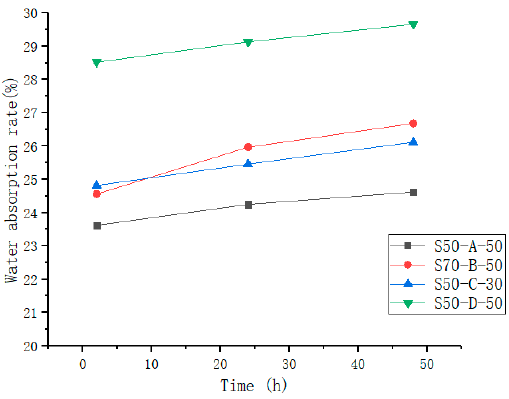
Figure 6. Water absorption rate of water-retentive mortar at different times.